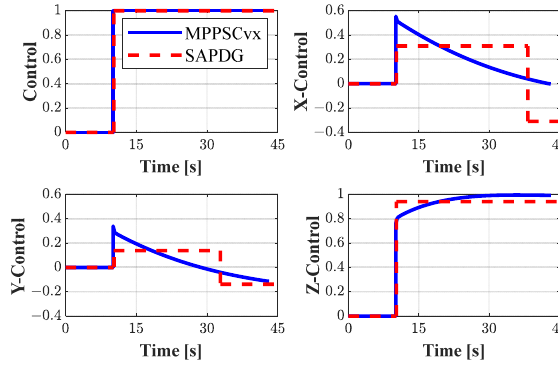
Figure 10. Control profile comparison of Example